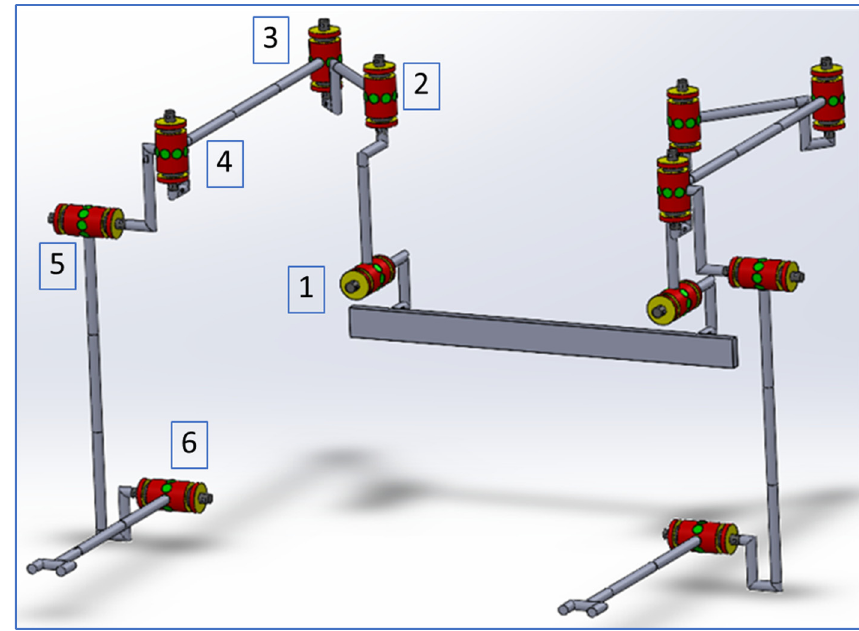
Figure 2. The exoskeleton kinematic scheme – motors labelled from 1 to 6.